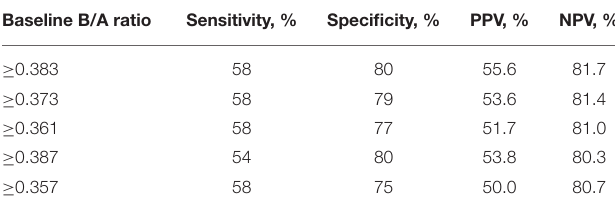
TABLE 3 | Baseline B/A ratios for predicting high-risk Kawasaki